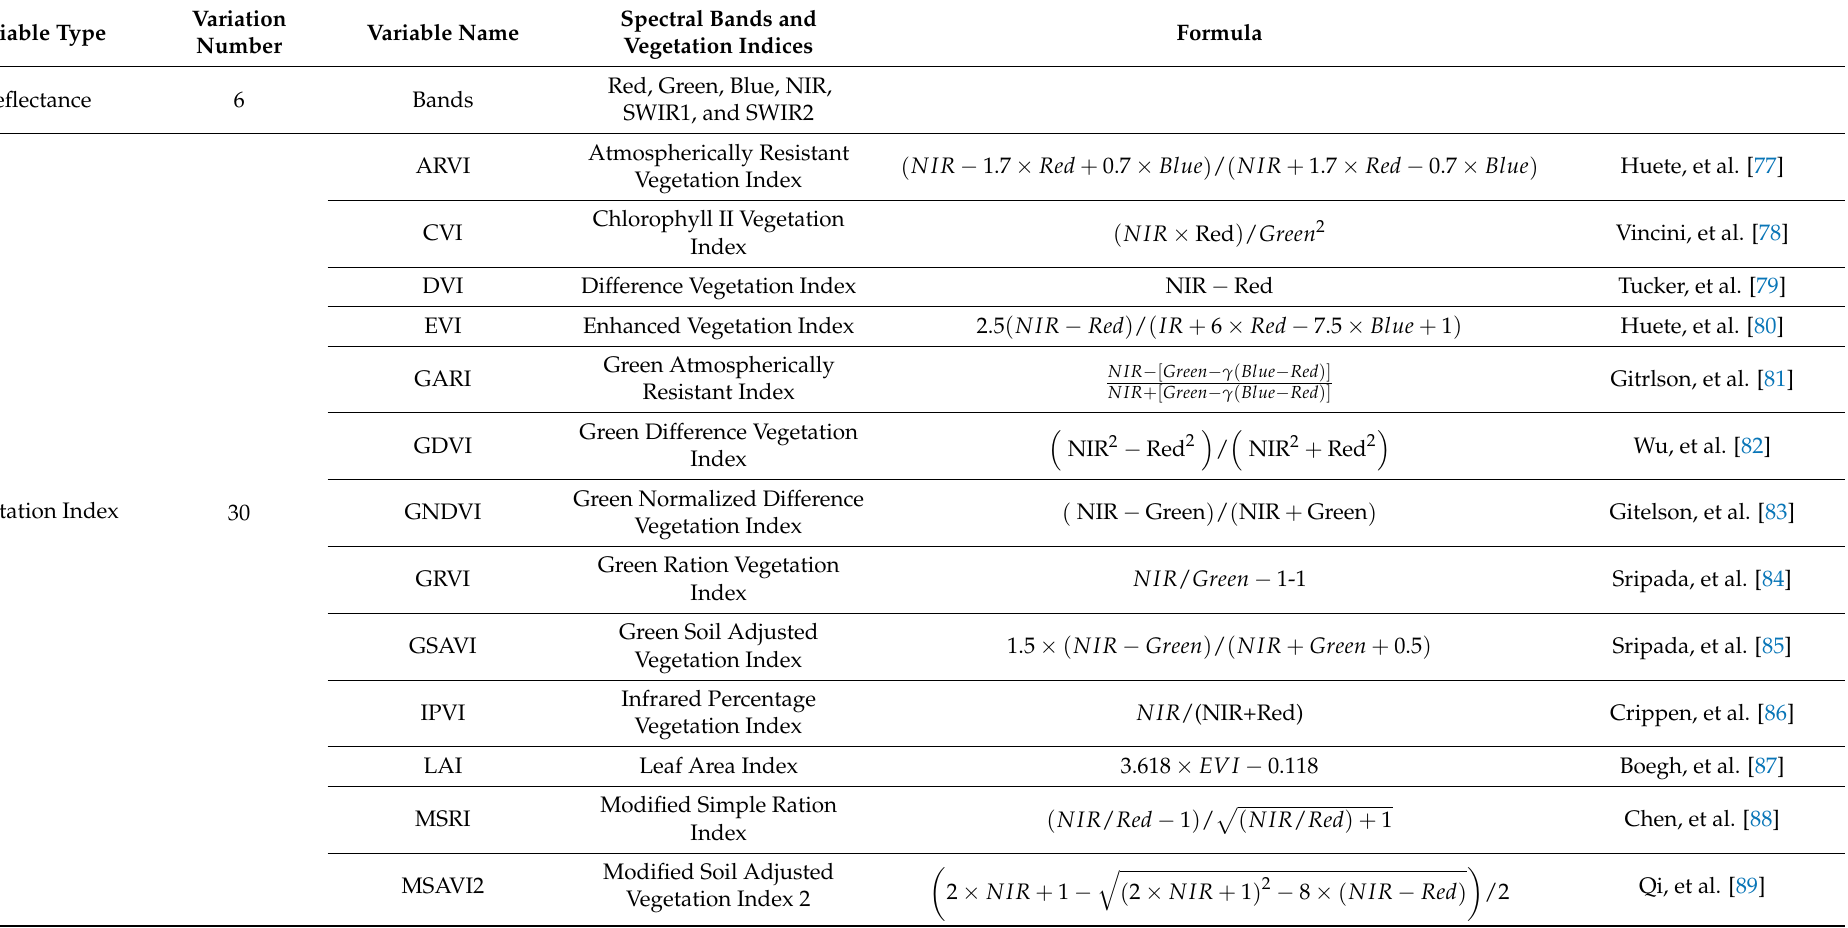
Table A2. List of